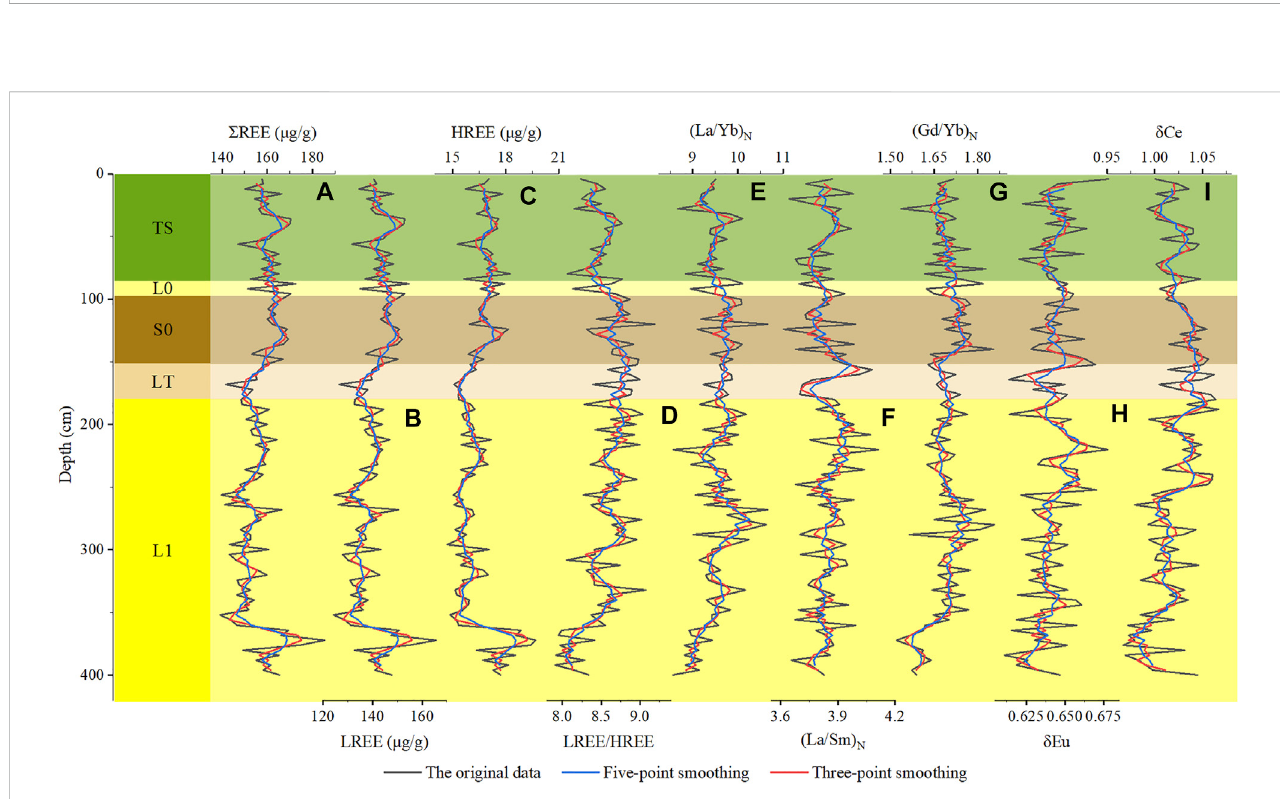
Variations ofdiverseparameters ofrare earthelements with depth inYHC pro fi le. (A – I) stand for Σ REE,LREE, HREE, LREE/HREE,(La/Yb) N ,(La/Sm) N , (Gd/ Yb) N , δ Eu and δ Ce, respectively; the black, blue, and red lines are drawn from data of original, fi ve-point smoothing and three-point smoothing,